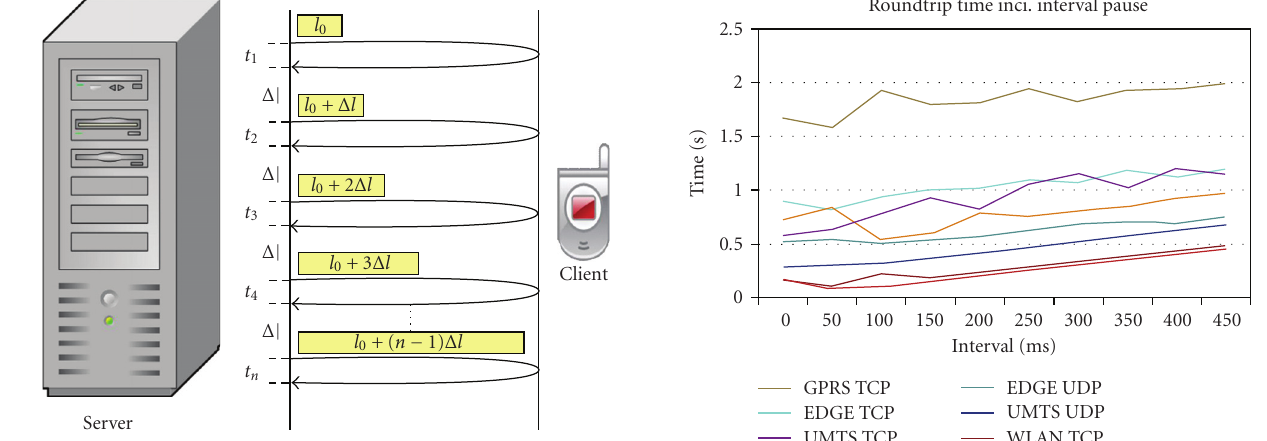
Figure 4: Measurement of transfer speed.